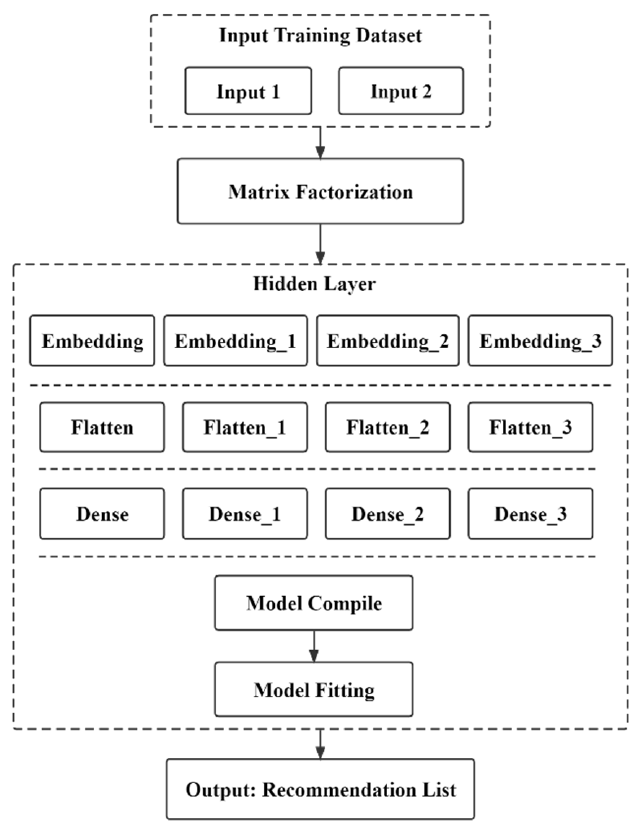
Figure 34. Schematic diagram based on matrix decomposition.